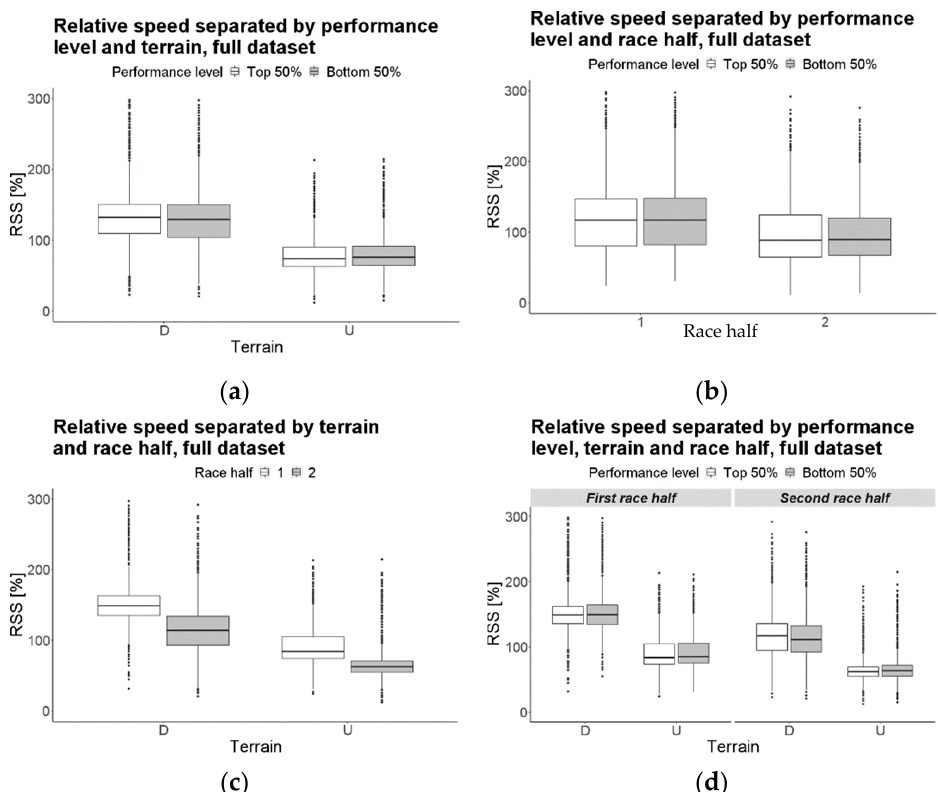
Figure 2. Boxplots representing the three two-way interactions ( a – c ) and the three-way interaction ( d ) of the full dataset model.